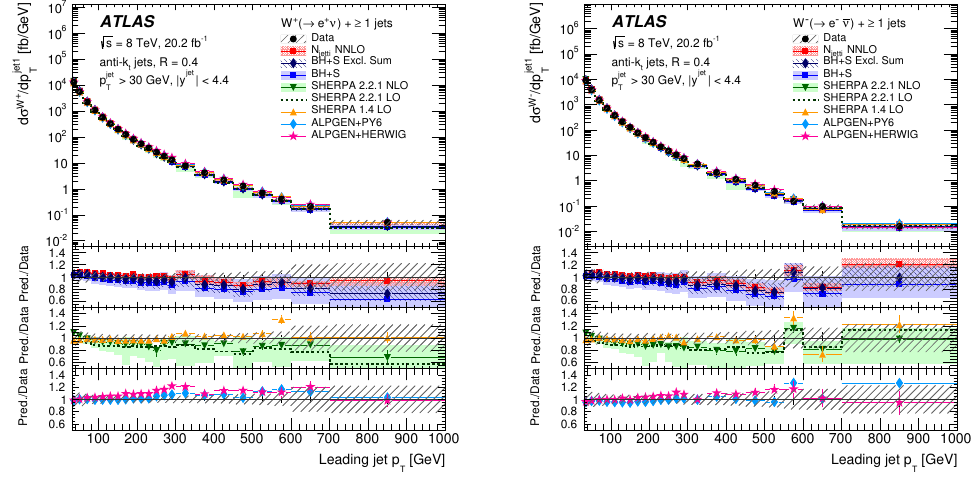
Figure 19 . Di(cid:11)erential cross sections for the production of W + (left) and W (cid:0) (right) as a function of the leading jet p T for events with N jets (cid:21) 1. For the data, the statistical uncertainties are indicated as vertical bars, and the combined statistical and systematic uncertainties are shown by the hatched bands. The uppermost panel in each plot shows the di(cid:11)erential cross sections, while the lower panels show the ratios of the predictions to the data. The theoretical uncertainties on the predictions are described in the text. The arrows on the lower panels indicate points that are outside the displayed range.